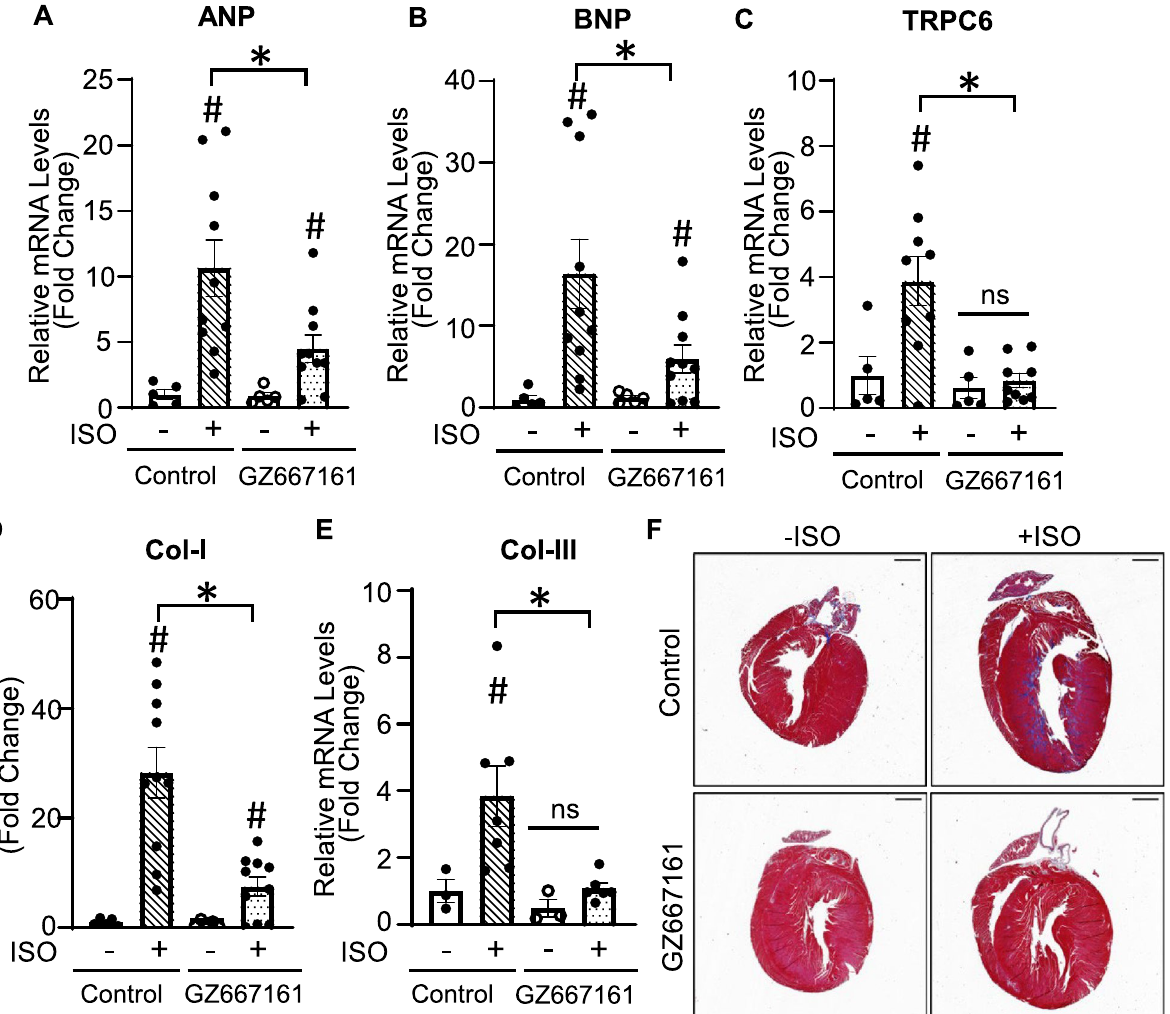
Figure 4. GZ667161 compound reduces expression of cardiac remodeling genes in the heart. ( A-E ) RNA from heart tissue was isolated and RT-qPCR was performed to examine the expression of cardiac remodeling genes in the heart in mice treated with or without ISO after 16 days of treatment. ( A ) ANP, ( B ) BNP, ( C ) TRPC6, ( D ) Col-I. ( E ) Col-III. ( F ) Representative trichrome staining for collagen fibers on ISO treated or untreated mice. Scale bar is 1 mm. − ISO (n = 5 per group). + ISO (n = 9–10 per group) # P < 0.05 − ISO vs + ISO. * P < 0.05 between indicated groups. ns, not significantly different between indicated groups. Data is expressed as mean ±